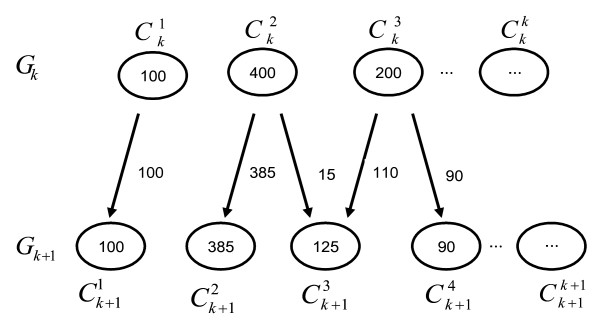
Behavior of cluster members during evolution. A few clusters in Gk continue as single clusters in Gk+1 while others disassociate or undergo leakage.